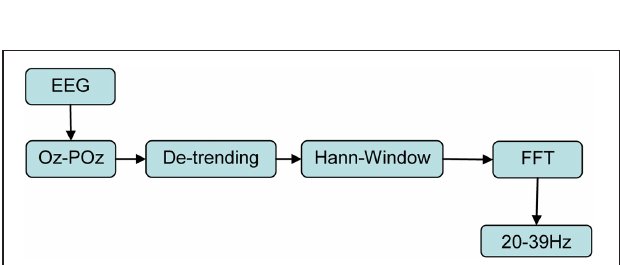
FIGURE 4 | Signal chain of acquisition and online preprocessing. Input signals are the time domain EEG signals at electrodes Oz and POz sampled at 1024Hz which finally result in normalized SSVEP spectral power densities S f for each of the 20 stimulation frequencies f using as transformation to frequency domain the Fast Fourier Transform